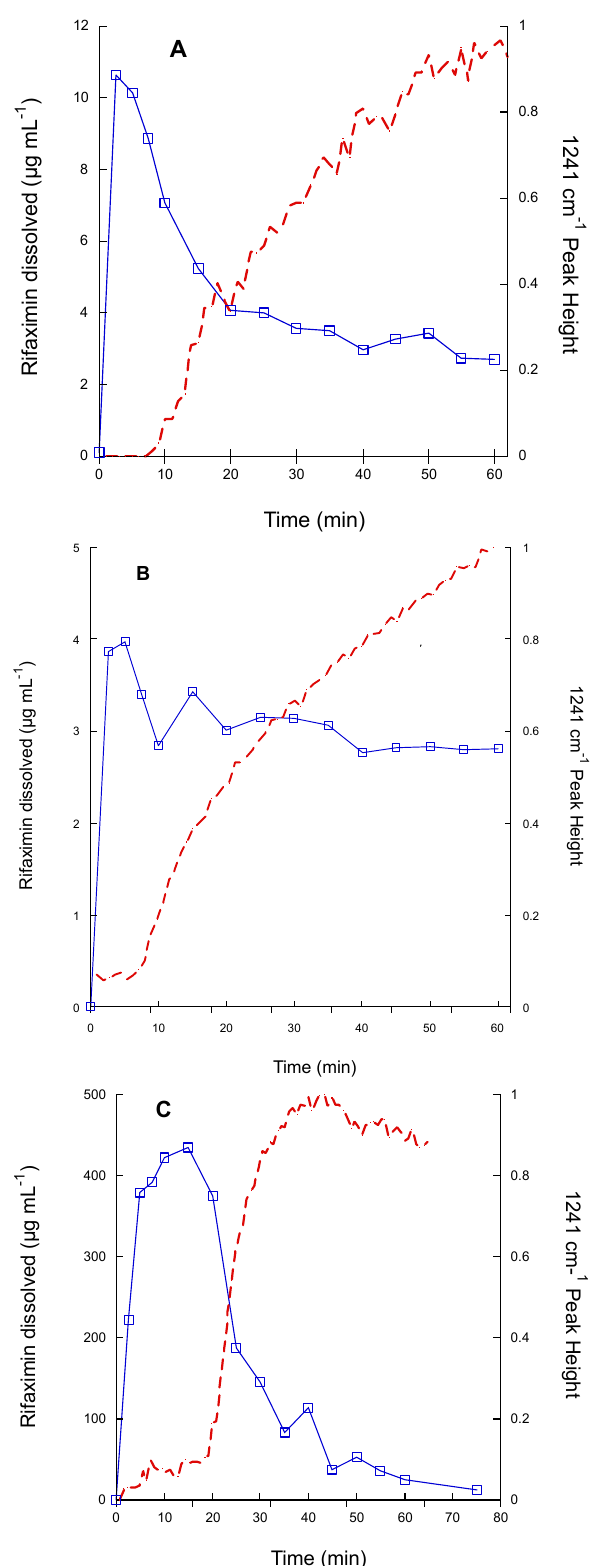
Figure 5. Concentration of rifaximin in solution at 20 ◦ C (line with squares) from two crystalline phases (( A ), α form; ( B ), β form) and an amorphous phase ( C ) along with the height of the ATR-FT-IR peak at 1241 cm − 1 (dashed line) represented as a function of